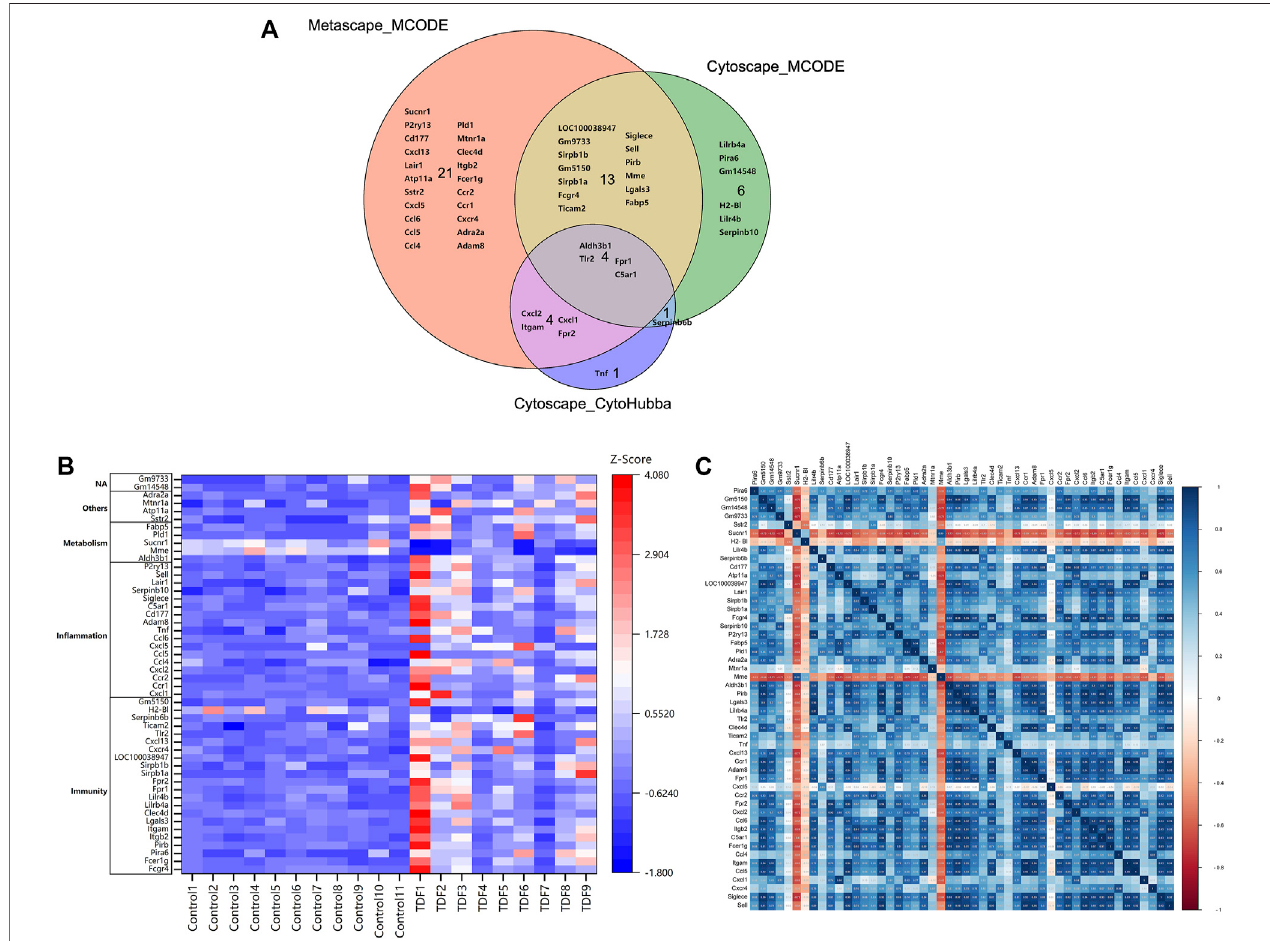
FIGURE 5 | Identi fi cation of signi fi cant genes. (A) A VENN diagram of the 50 signi fi cant union genes among “ Metascape_MCODE1, ” “ Cytoscape_MCODE1, ” and “ Cytoscape_cytoHubba. ” (B) Hierarchicalclusteringheatmapandbiologicalfunctionalclassi fi cationofthe50signi fi cantgenes. (C) Pearsoncorrelationanalysisofthe50 signi fi cant